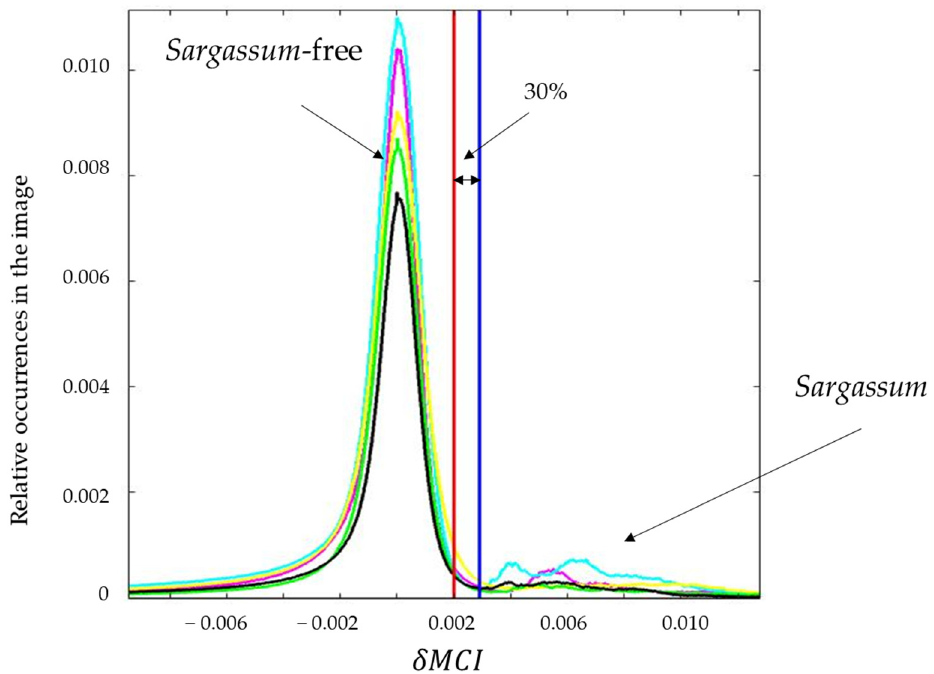
Figure 7. Histograms (number of occurrences) of δ MCI for each of the Sentinel-3/OLCI scenes. The histograms are represented for 8 July 2017 13:00 (black line), 27 May 2018 14:24 (yellow line), 9 May line). The red vertical line shows the threshold value of 0.002 that has been adopted for this study. Such a value is 30% lower than the minimum value of δ MCI observed between the two modes (blue vertical line).